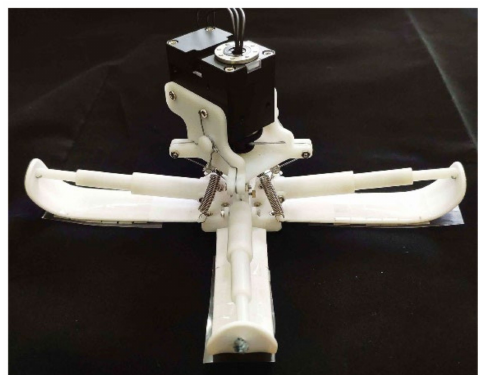
Figure 11. Gecko-inspired